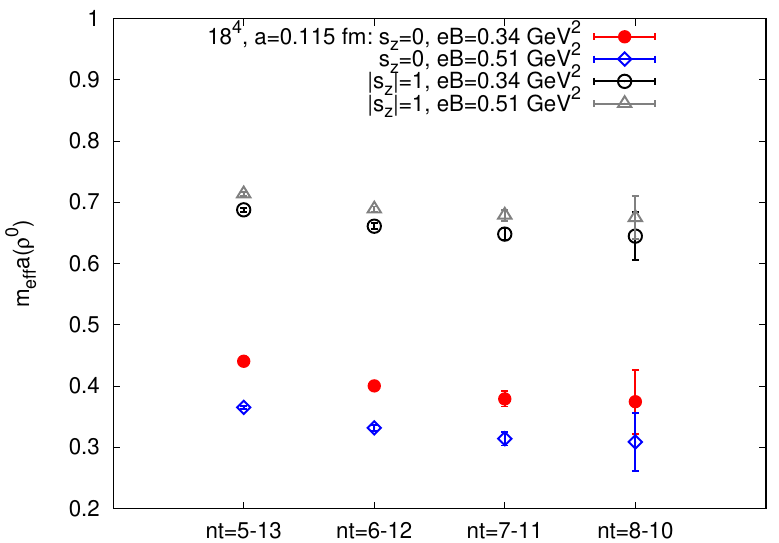
Figure 1 . The m e(cid:11) stability plot of the (cid:26) 0 -meson for the spin projections s z = 0 and j s z j = 1 on the magnetic (cid:12)eld axis depending on the n t (cid:12)t ranges. The results were obtained on the lattice with the volume 18 4 , the lattice spacing 0 : 115 fm and the pion mass m (cid:25) = 541